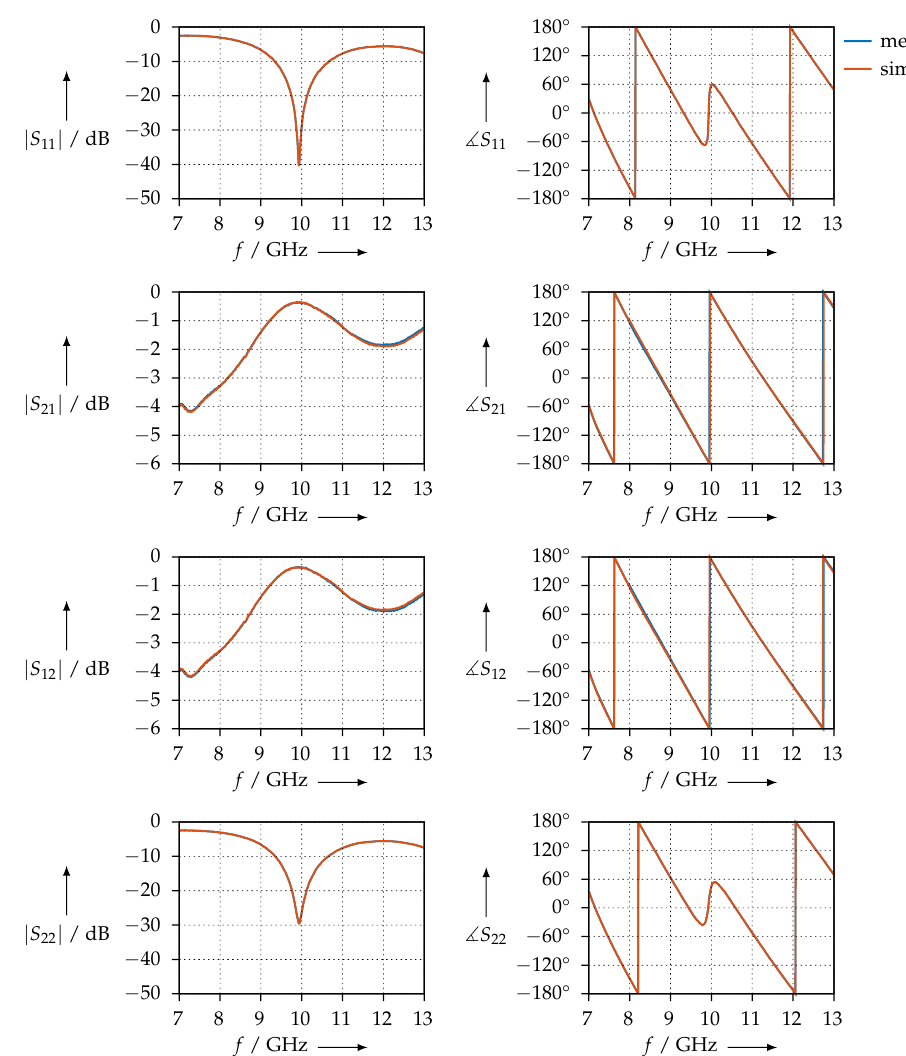
Figure 19. Measured and simulated S-parameters of the PLA sample in the waveguide.